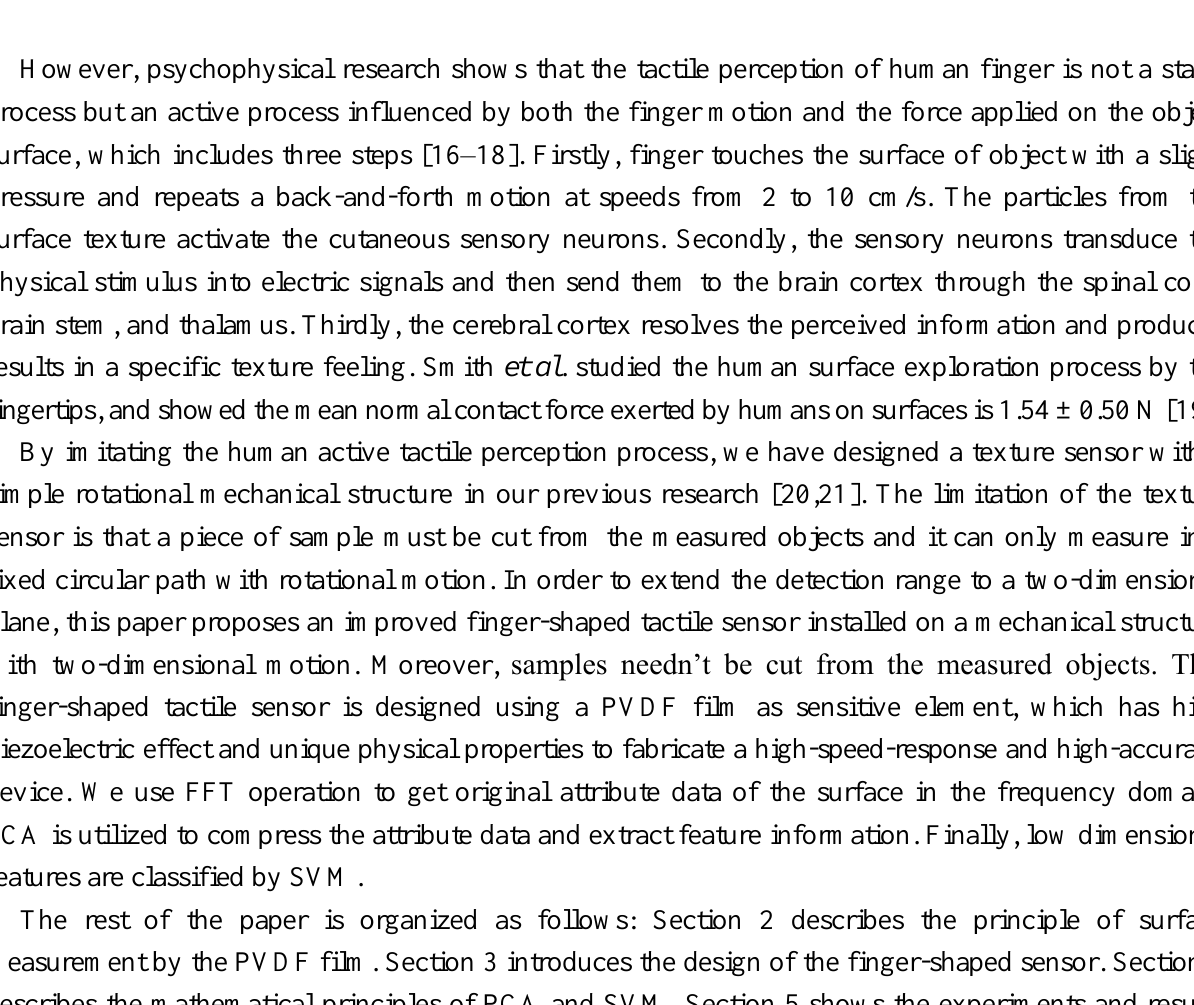
, d , d are the piezoelectric strain coefficient of the 31 32 33 ≥ d > d > 0. The coefficients d , d are the piezoelectric 33 31 32 24 15